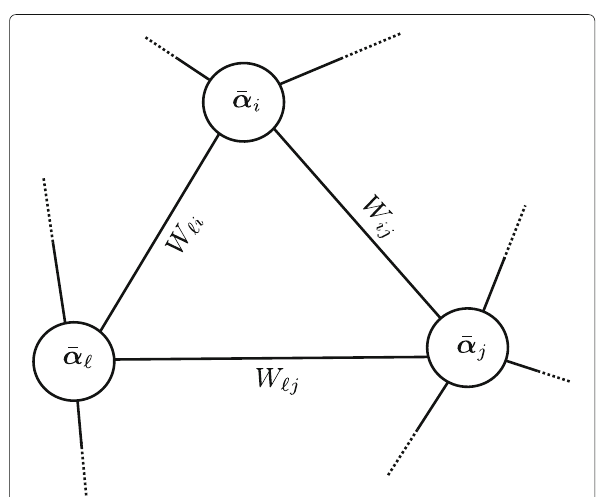
Fig. 3 Part of an undirected graph where motor data vectors ¯ α (cid:2) , (cid:2) = 1, ... , L are the nodes of the graph. The weights of the edges are given by Eq. 6: the more similar two motor data vectors are, the larger the weight of the connecting edge is